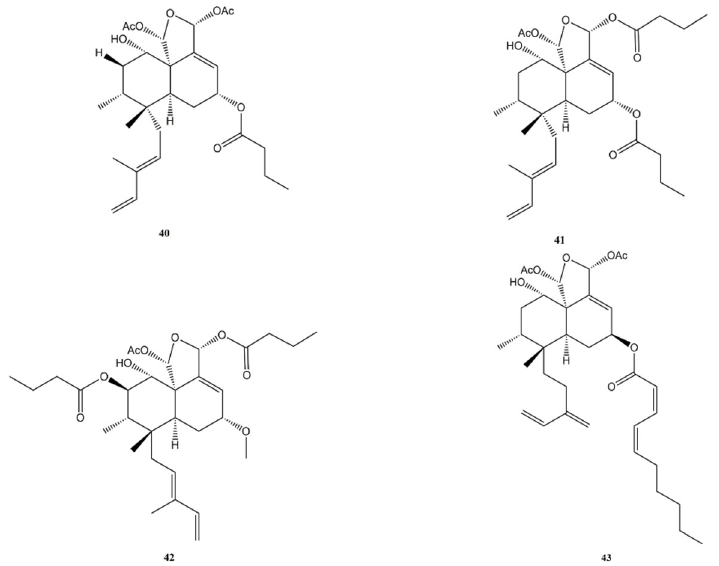
Figure 8. Bioactive clerodane diterpenes: Caseargrewiin F ( 40 ); Casearin X ( 41 ); Casearin J ( 42 ); Corymbulosin A ( 43